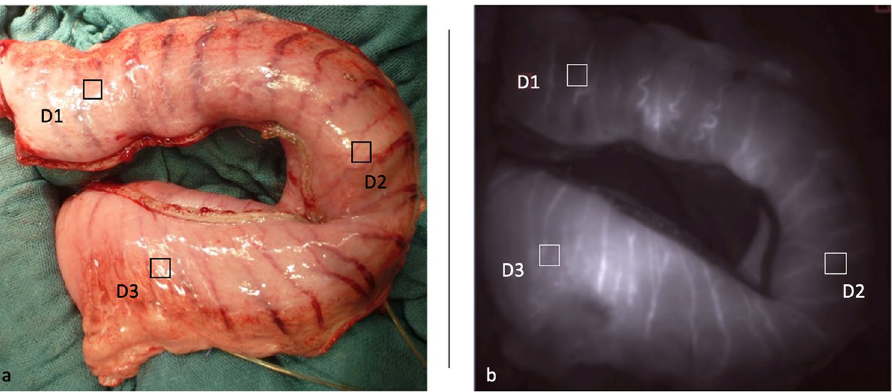
Figure 1. Macroscopic and fluorescent image of the gastric tube. The left picture ( a ) shows the macroscopic picture of the gastric tube. Three regions of interest (ROI) are marked: The prepyloric region (D3), the corpus (D2), and the tip (D1). The right picture ( b ) shows the associated fluorescence angiographic image of the gastric tube with the same marked